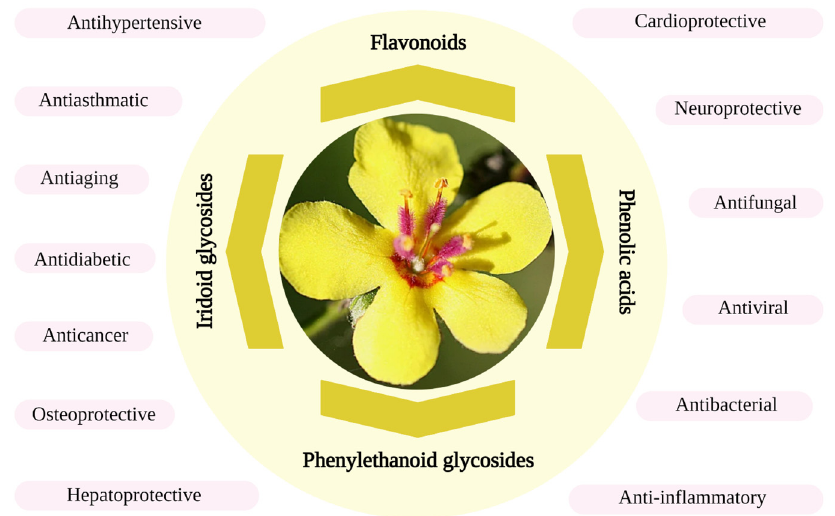
Figure 1. Health benefits of bioactive compounds identified in Verbascum sinuatum.